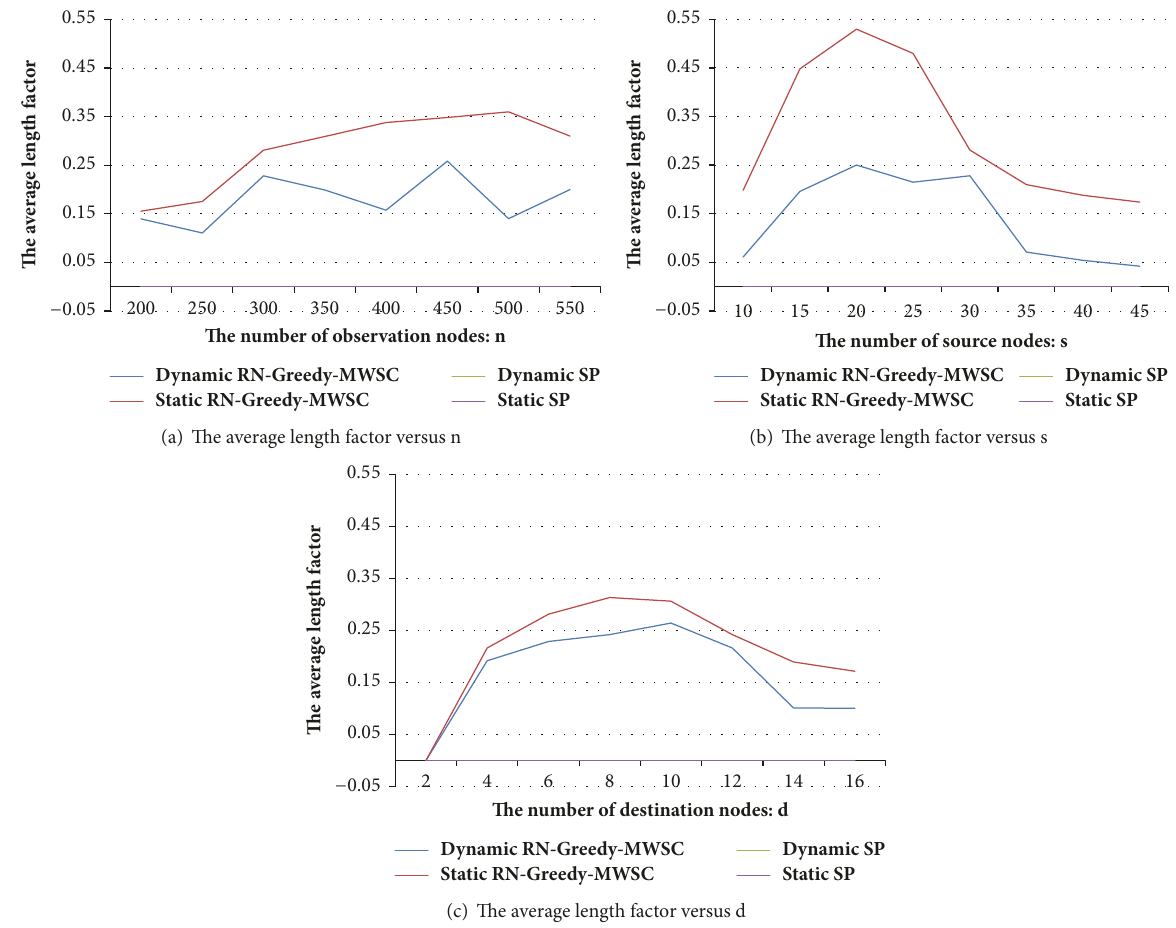
Figure 4: Performance on the average length